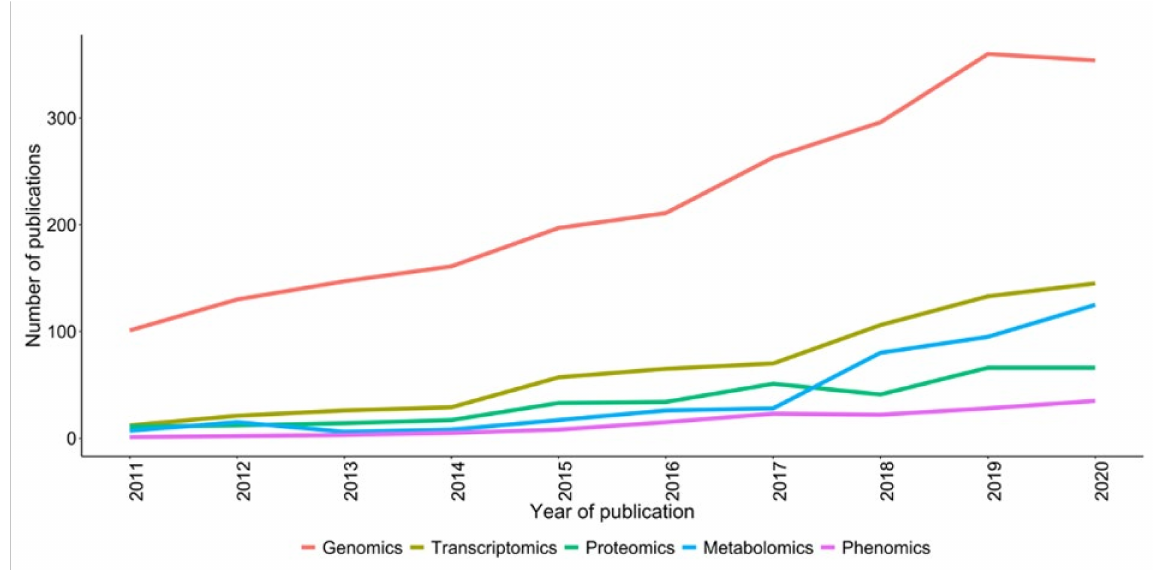
Figure 3. Graphical presentation showing the trend of publications mentioning omic approaches to improve fodder crops in the last decade. The search was made using the associated omics